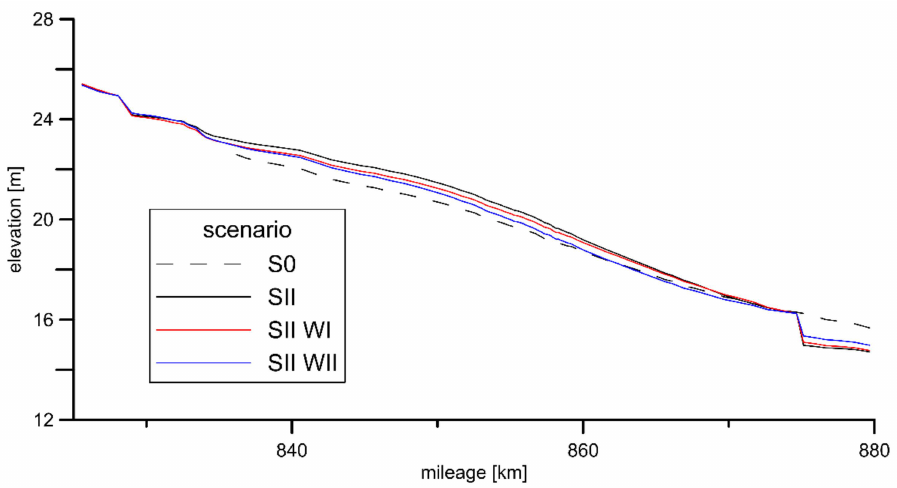
Figure 15. Difference in the bottom elevation between Scenarios S0 and SII, as well as options SII WI and SII WII for the Q 0.2%